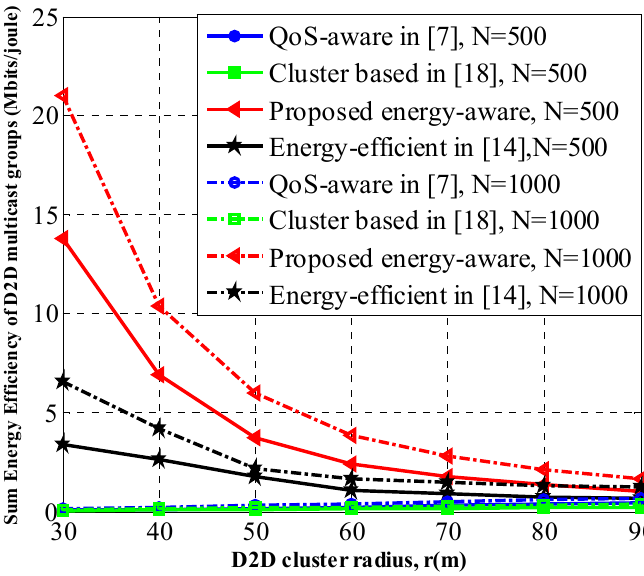
Figure 2. Cluster Energy Efficiency versus D2D cluster radius. QoS: quality of service .